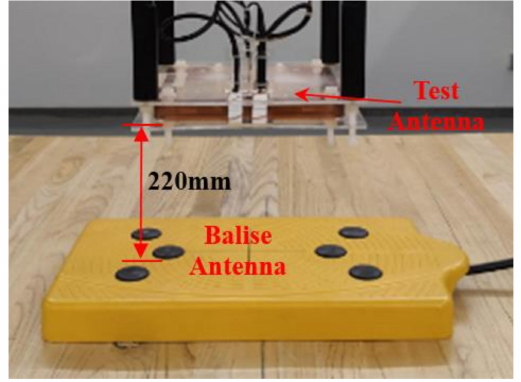
Figure 8. Balise input–output characteristics test scenario.